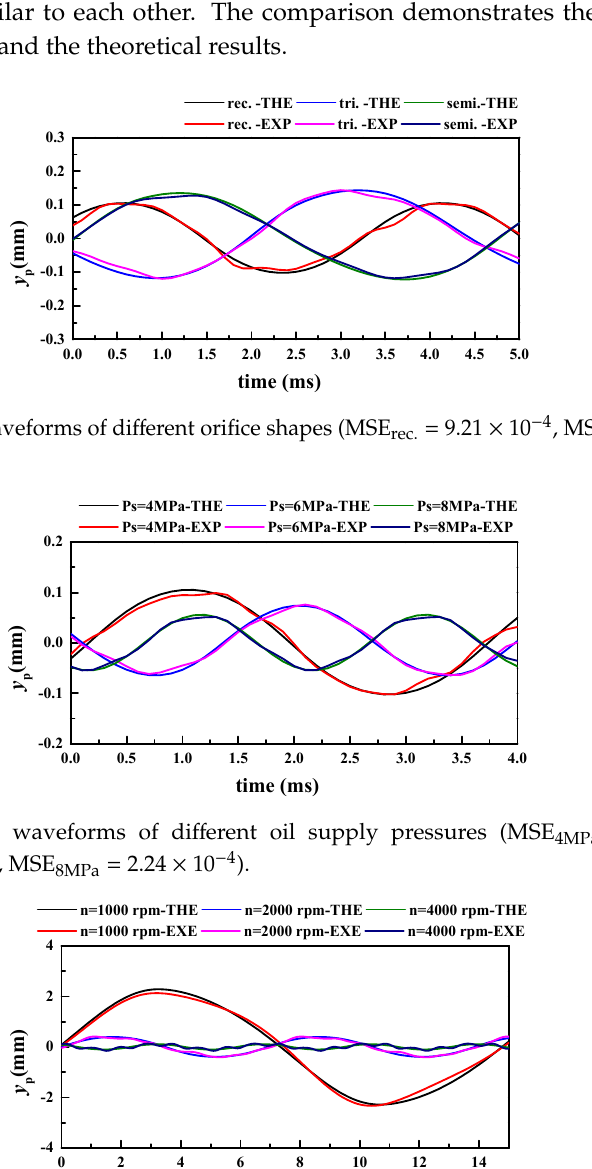
Mass blockMicro-displacement double-functioned hydraulic cylinder Figure 39. Electro-hydraulic vibration exciter. Table 2. The specifications of the experimental setup. Device